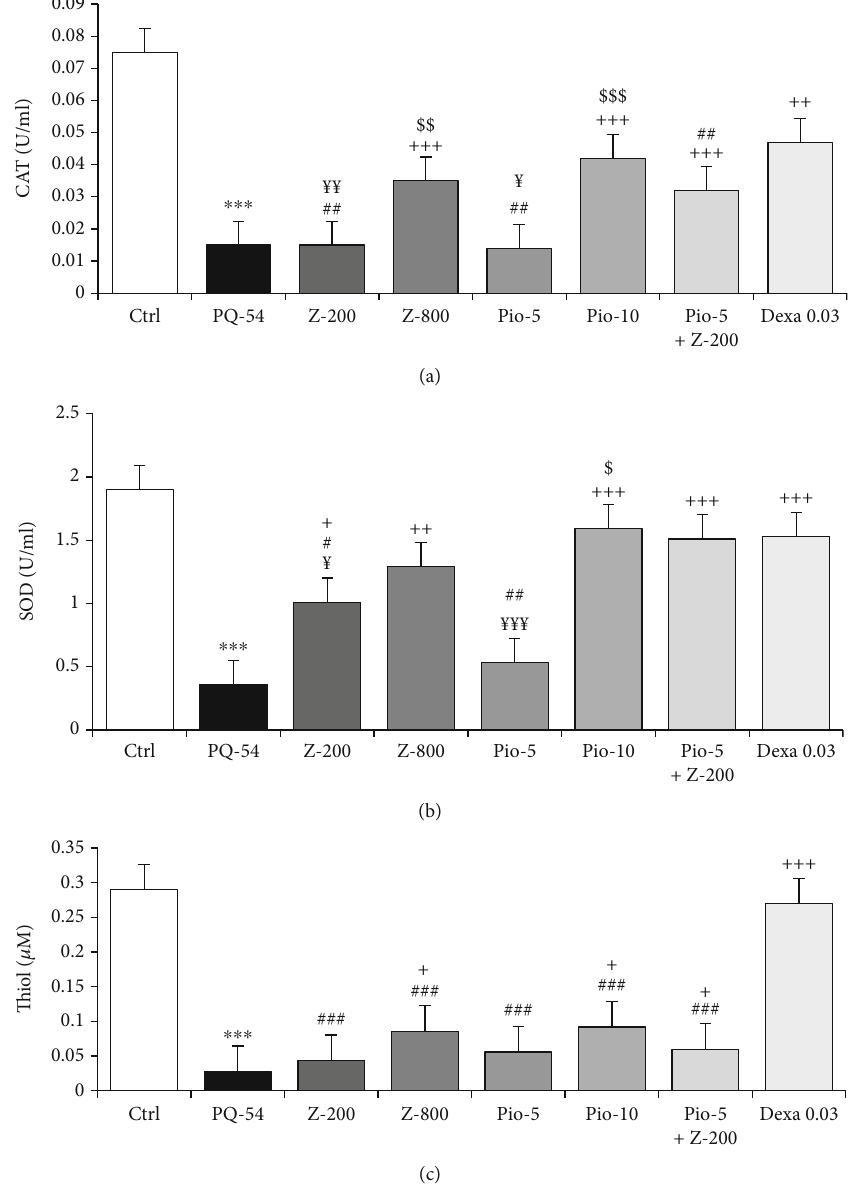
Figure 4: Serum levels of catalase (CAT) (a), superoxide dismutase (SOD) (b) activities, and thiol concentration (c) of the control group (Ctrl), group exposed to paraquat aerosol at doses of 54mg/m 3 (PQ-54), and groups exposed to PQ-54mg/m 3 and treated with 5 and 10mg/kg/day pioglitazone, 200 and 800 mg/kg/day Zataria multi fl ora , 0.03mg/kg/day dexamethasone, and 5 mg/kg/day pioglitazone + 200 mg/kg/day Zataria multif lora (Pio-5, Pio-10, Z-200, Z-800, Dexa 0.03, and Pio- 5 + Z -200, respectively). The results are expressed as the mean ± SEM ( n = 6 in each group). ∗∗∗ p < 0 : 001 compared to the control group. + p < 0 : 05 , ++ p < 0 : 01 , and +++ p < 0 : 001 compared to the PQ group. # p < 0 : 05 , ## p < 0 : 01 , and ### p < 0 : 001 compared treatment with other dexamethasone-treated groups. $ p < 0 : 05 , $$ p < 0 : 01 , and $$$ p < 0 : 001 compared to low dose of Zataria multi fl ora and pioglitazone groups. ¥ p < 0 : 05 , ¥¥ p < 0 : 01 , and ¥¥¥ p < 0 : 001 compared to the Pio ‐ 5mg/kg + Z ‐ 200mg/kg group. Comparisons between di ff erent groups were made using one-way ANOVA followed by Tukey ’ s multiple comparison synergistic e ff ect for these two agents. This synergistic e ff ect may indicate the e ff ect of Z . multi fl ora extract on PPAR- γ receptors. The activated PPAR- γ receptors and inhibited COX-2, by carvacrol, the main constituent of Z. multi fl ora , support the potential e ff ect of Z. multi fl ora on PPAR- γ recep- tors [22].